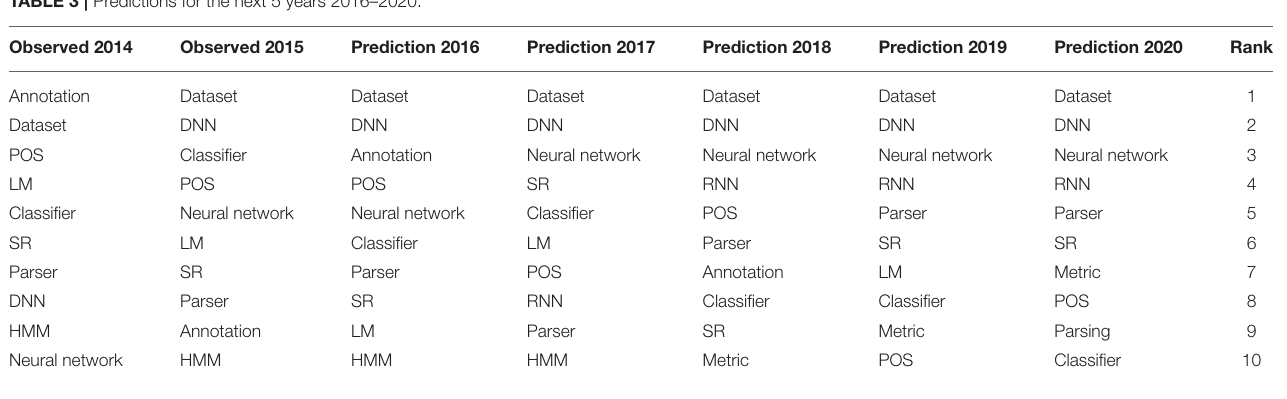
TABLE 3 | Predictions for the next 5 years